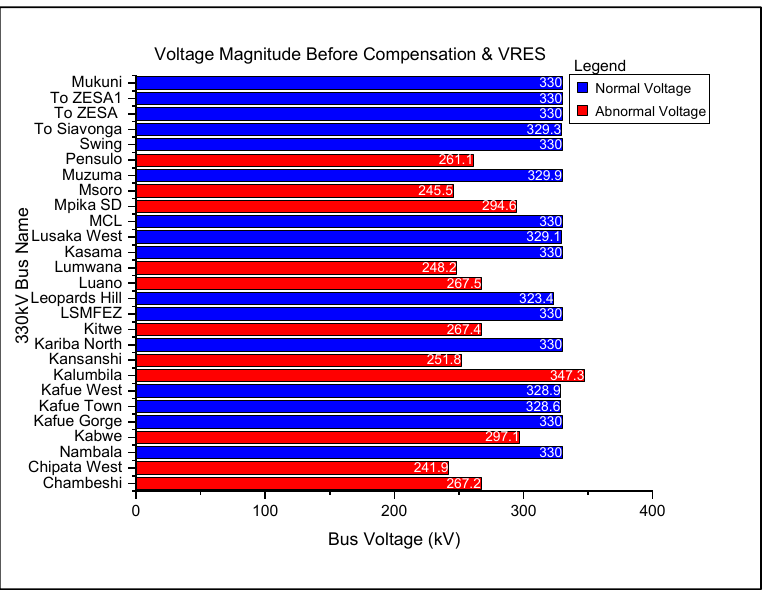
Figure 8. Figure showing the existing 330 kV bus voltage profile without VRES integration and reactive compensation at Luano, Kansanshi, Lumwana, Kitwe, Kalumbila, and Chipata West network buses.